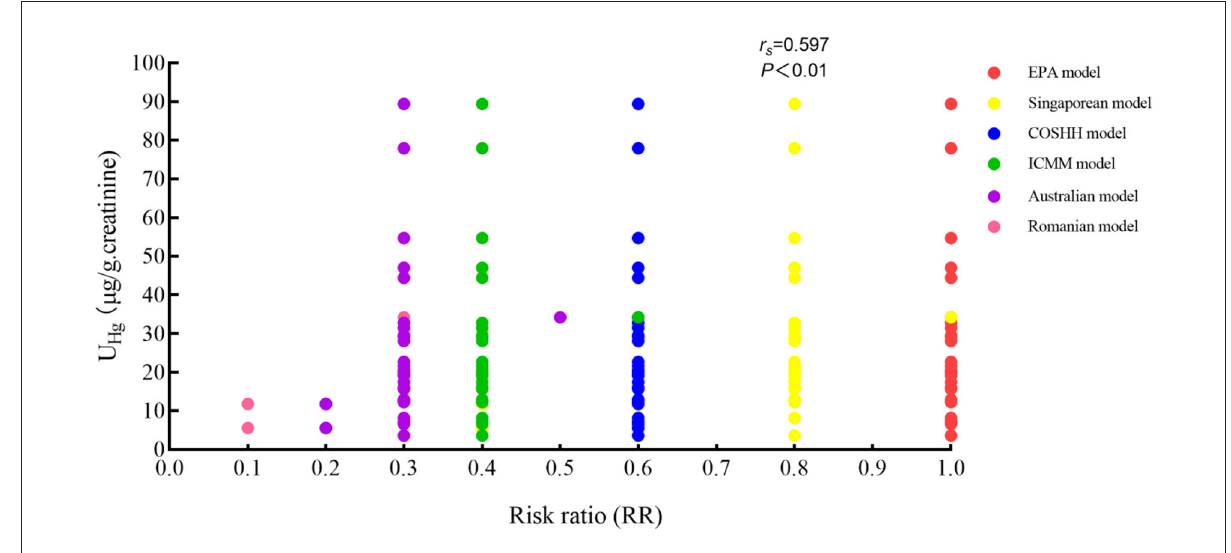
FIGURE2 Correlation indices between U Hg and RRs with different OHRA